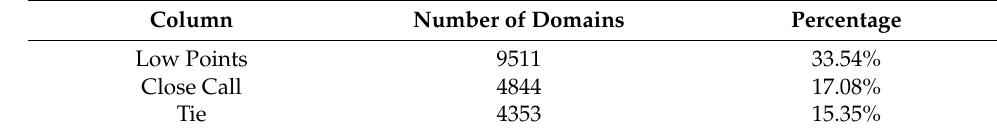
Table 7. Domains with .eu ccTLD that were decided.